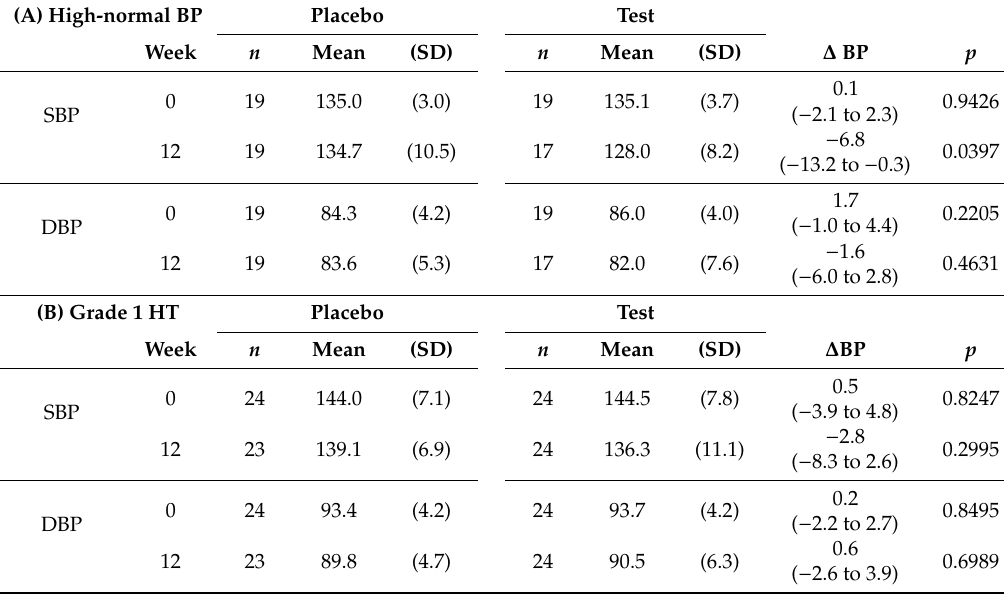
Table 4. Results from the stratified analysis.